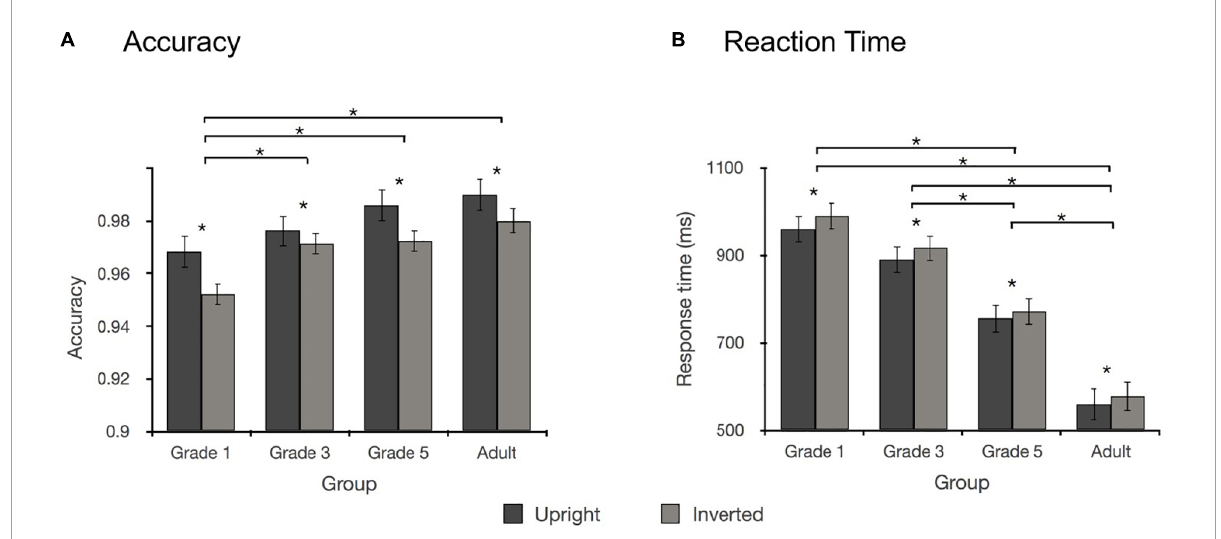
FIGURE2 (A) The impact of the inversion effect on accuracy in Experiment 1. (B) The impact of the inversion effect on RT in Experiment 1. Error bars represent the standard error of the mean. * p <